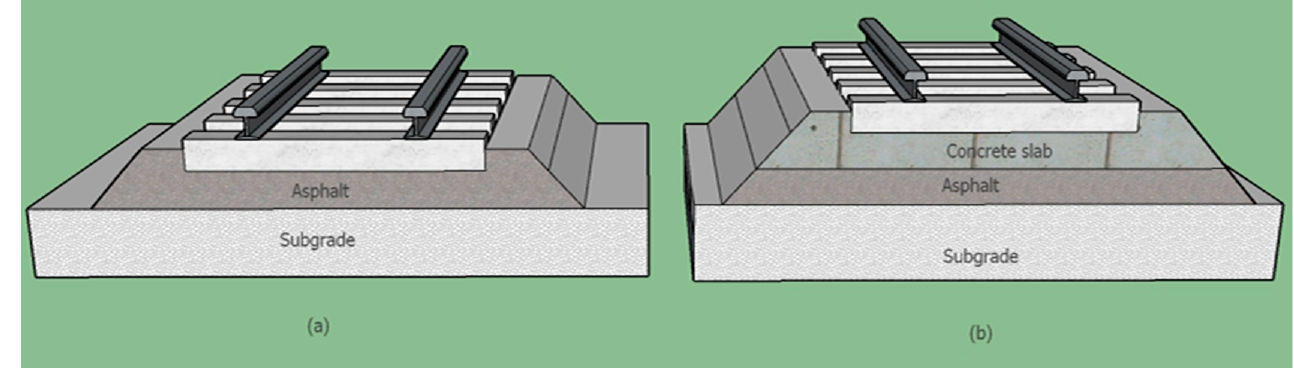
Figure 2. Schematic of combinations of ballastless layers in a track bed: ( a ) asphalt slab track and ( b ) asphalt between concrete slab and subgrade.